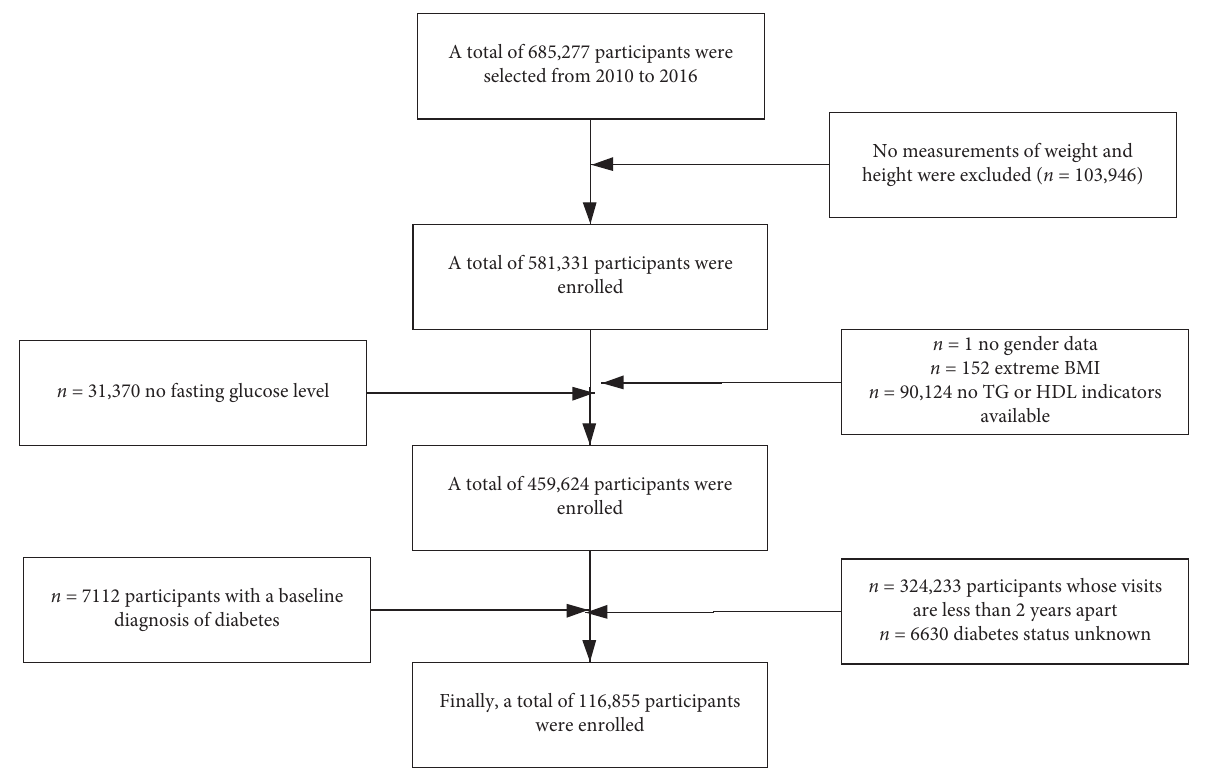
Figure 1: Flowchart of patient